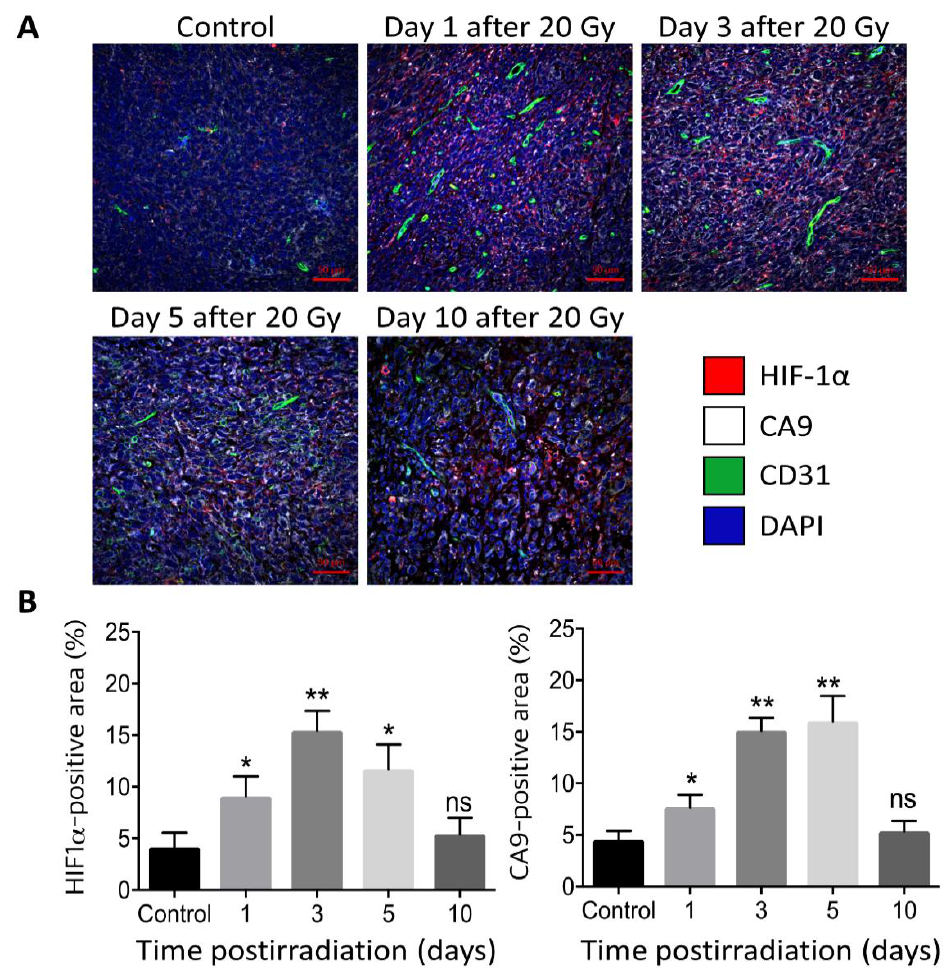
Figure 2. (Upper panel) ( A ). Immunohistochemical image of HIF-1α (magenta), CA9 (white), CD31 (green) and DAPI (blue) in FSaII tumors grown subcutaneously in the legs of C3H mice. (Lower panel) ( B ). % Positive area for HIF-1α and CA9. Irradiation with 20 Gy markedly increased the